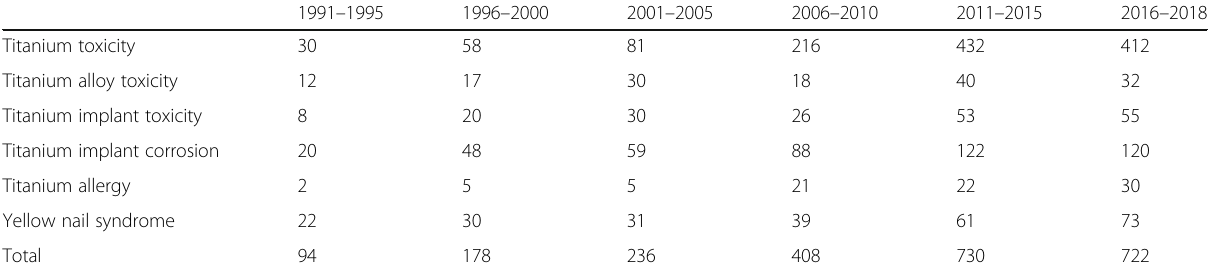
Table 1 Number of articles representing each titanium toxicity trend according to year